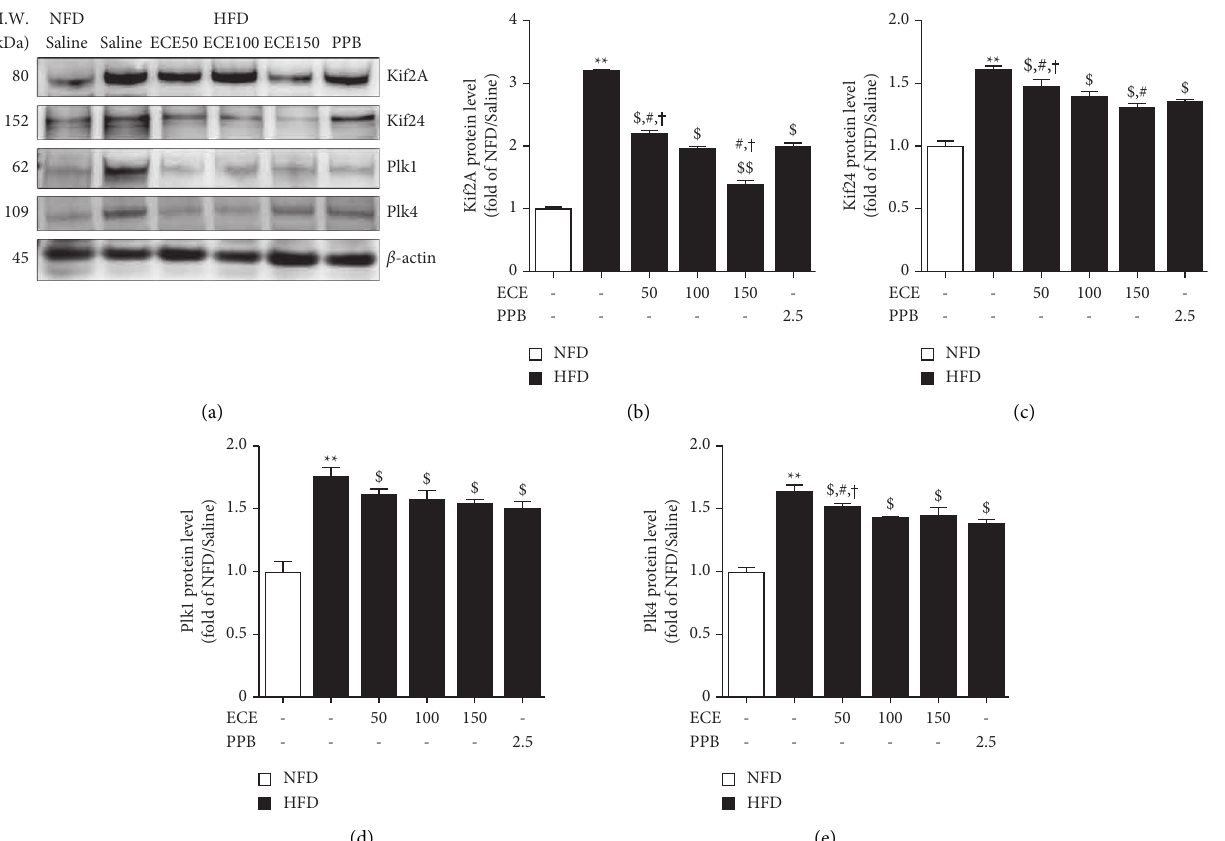
Figure 4: ECE and PPB modulated the cilia pathway in visceral adipose tissue of mice fed HFD. (a) The protein expression levels of Kif2A, Kif24, Plk1, and Plk4 in visceral adipose tissue of mice fed HFD were measured by Western blot. ((b)–(e)) Quantitative graphs of representative Western blot images. The protein expression levels were normalized to β -actin. Increased protein expression levels were restored by ECE and PPB administration. All data are shown as mean ± S.D. ∗∗ , p < 0 . 01, vs. NFD/saline; $ p < 0 . 05 and $$ p < 0 . 01, vs. HFD/ saline; # p < 0 . 05, vs. HFD/ECE100; † p < 0 . 01, vs. HFD/PPB (Mann–Whitney U test). ECE, ecklonia cava extract; HFD, high-fat diet; Kif2A, kinesin family member 2A; Kif24, kinesin family member 24; NFD, normal fat diet; Plk1, Polo-like kinase 1; Plk4; polo-like kinase 4, PPB, pyrogal-lol-phloroglucinol-6,